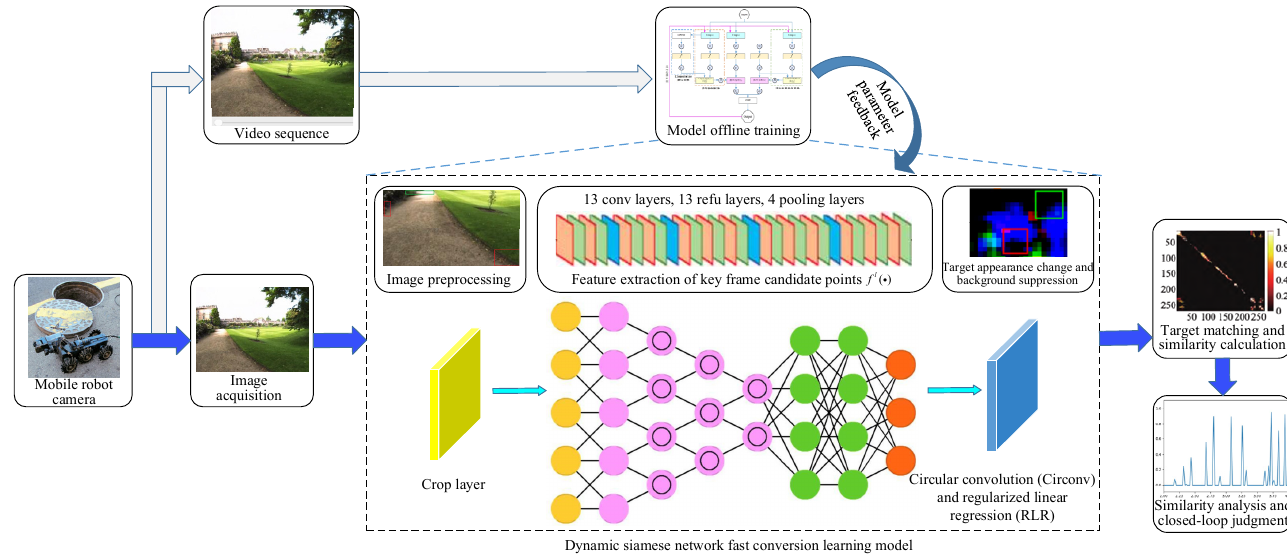
Figure 1. Execution flow of the real-time closed-loop detection method.